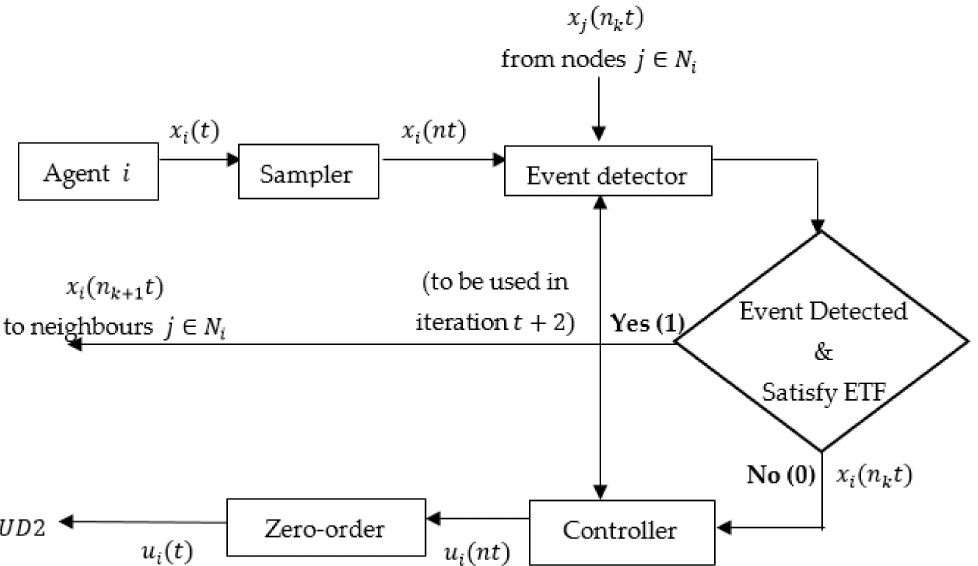
Figure 5. Agent i event-triggered controller, γ